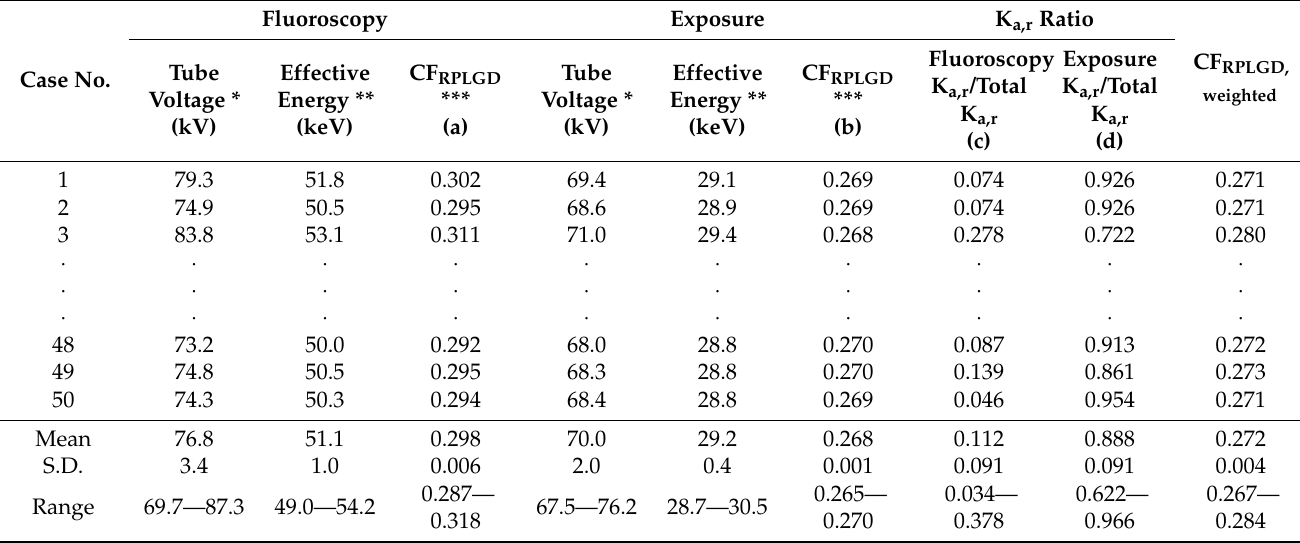
Table 3. Radio-photoluminescence glass dosimeter (RPLGD) energy compensation factors weighted by the ratio of the dose at the patient entrance reference point (K a,r ratio) (test data set: n = 50).